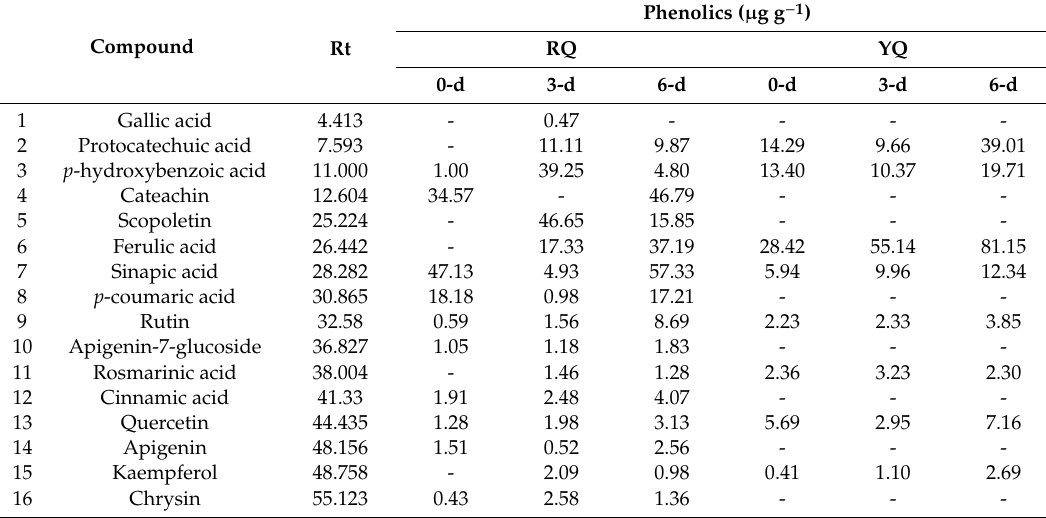
Table 2. High-performance liquid chromatography-diode array detection (HPLC-DAD) based identification and quantification of phenolic compounds in yellow and red quinoa seeds and sprouts during 6 days of germination at 17 ± 1 ◦ C and 90–93% relative